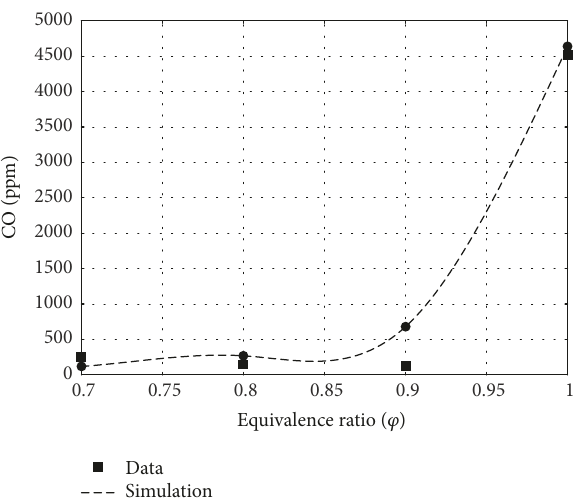
Figure 3: Comparison of predicted engine-out CO with experimental data for various equivalence ratios.